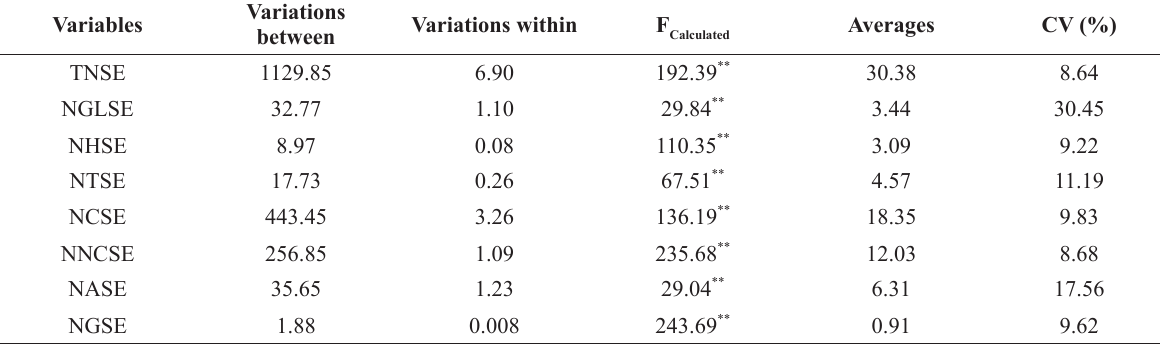
Analysis of variance for total number of somatic embryos (TNSE), number of globular embryos (NGLSE), number of heart- shaped embryos (NHSE), number of torpedo-shaped somatic embryos (NTSE), number of cotyledonary embryos (NCSE), number of normal cotyledonary embryos (NNCSE), number of abnormal cotyledonary embryos (NASE), and number of